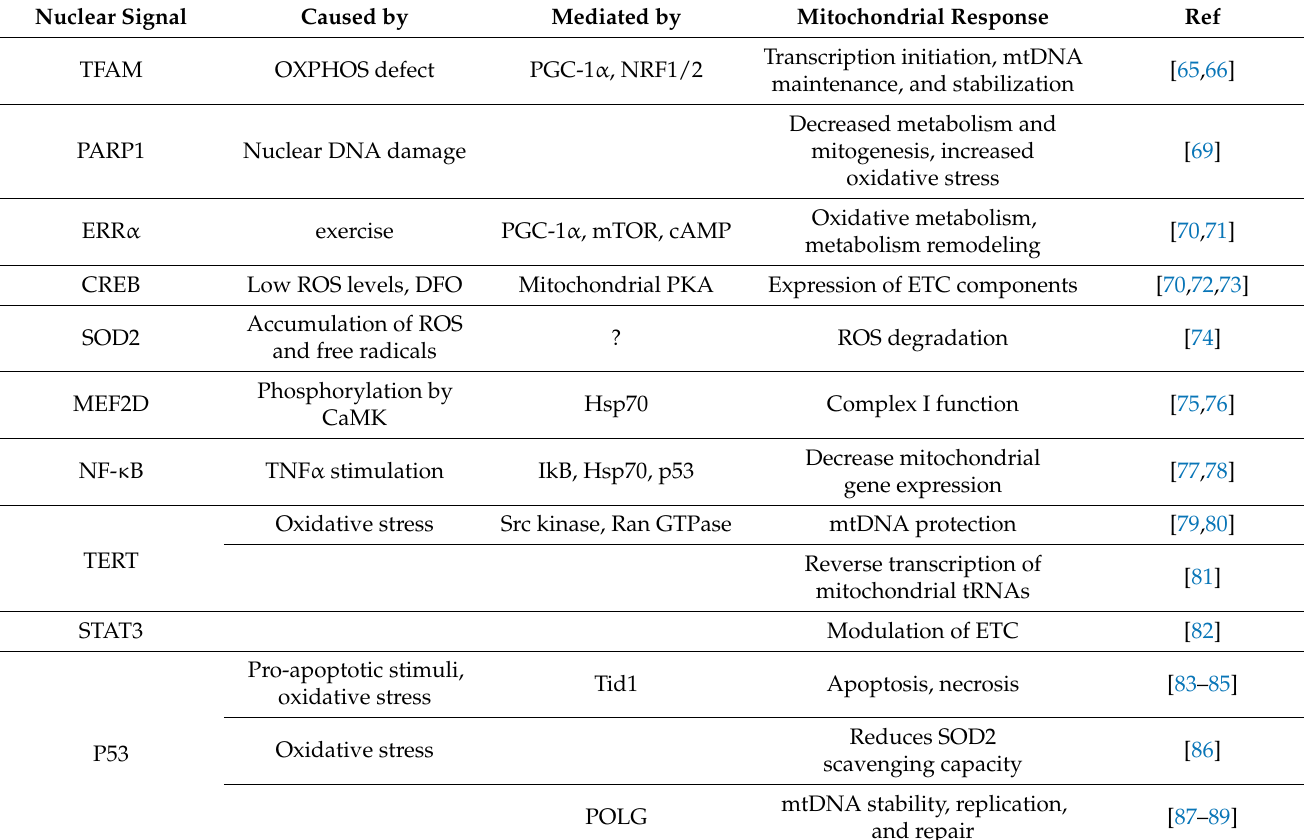
Table 1. Nuclear effectors of mitochondrial